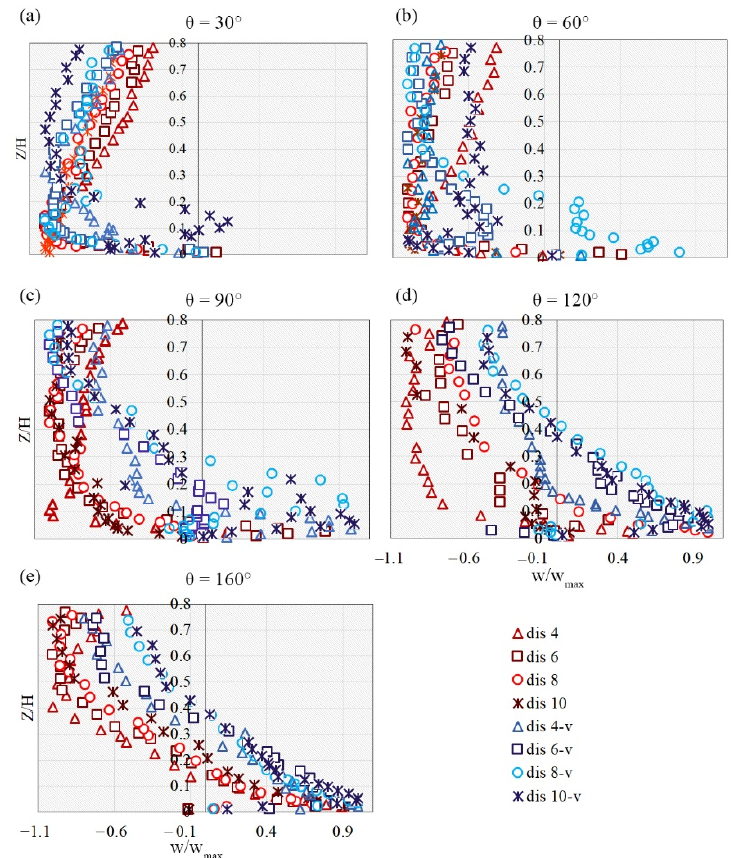
Figure 14. Comparison of the normalized vertical velocity ( w ) at the azimuthal planes with specific distances from the abutment surface for the un-vegetated bed (marked by red symbols) and the vegetated bed (marked by blue symbols).